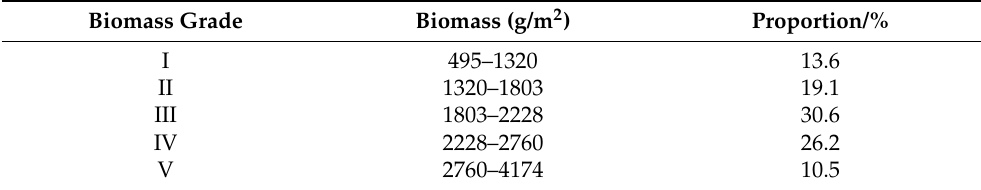
Table 6. Biomass classification of Sargassum thunbergii in the sample area based on GBDT model inversion. Biomass Grade Biomass (g/m 2 ) Proportion/%